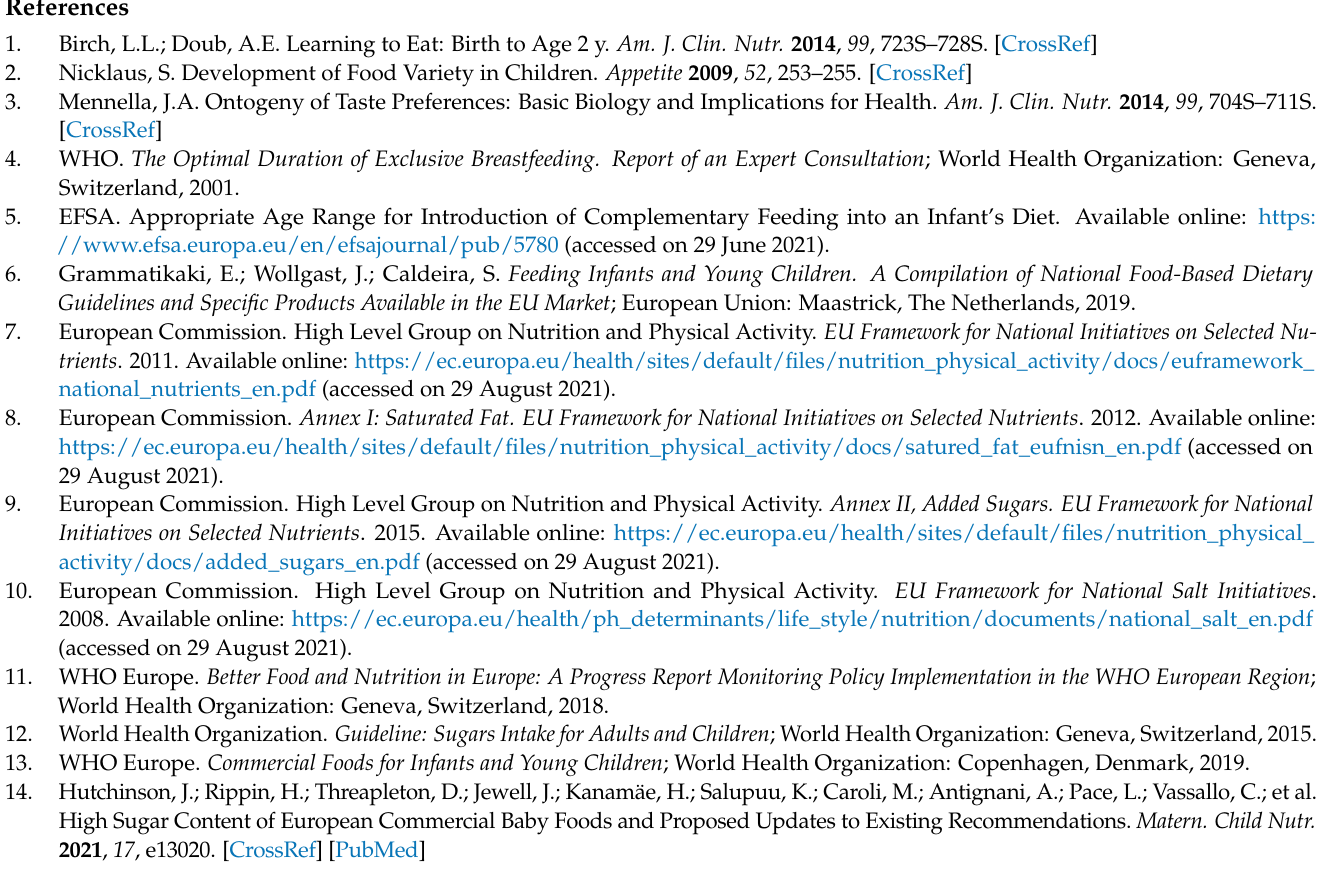
Figure A8. Nutrient content (g/100 kcal product, except for sodium mg/100 kcal product) of ‘Other baby food’.